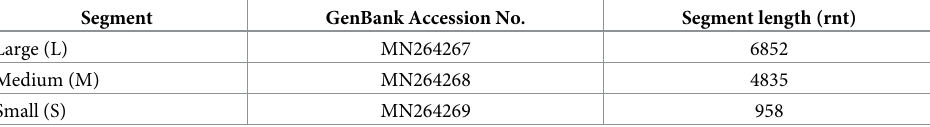
Table 4. GenBank accession nos. and segment lengths (rnt) of OROV Homo sapiens/Haiti-1/2014.